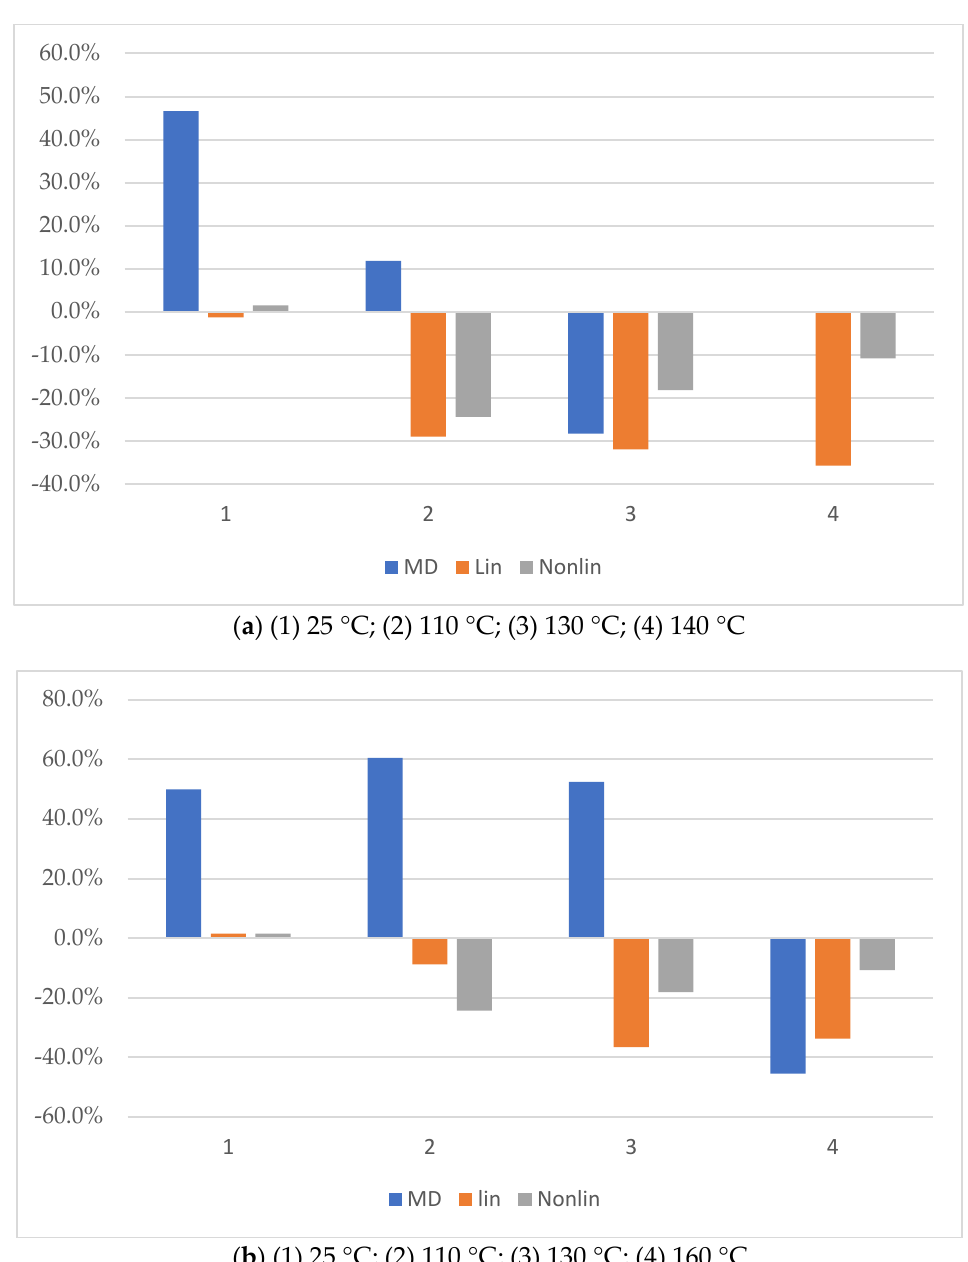
Figure 12. Percent error to the experimental value of the modulus of elasticity of FRP (( a ) before thermal aging, ( b ) after thermal aging) for the predicted value obtained from the results: (MD) simulation in Material Designer for a reinforced monolayer; (lin) for the linear solution of a multilayer composite bending in ANSYS APDL; (Nonlin) for the nonlinear solution of a multilayer composite bending in ANSYS APDL .